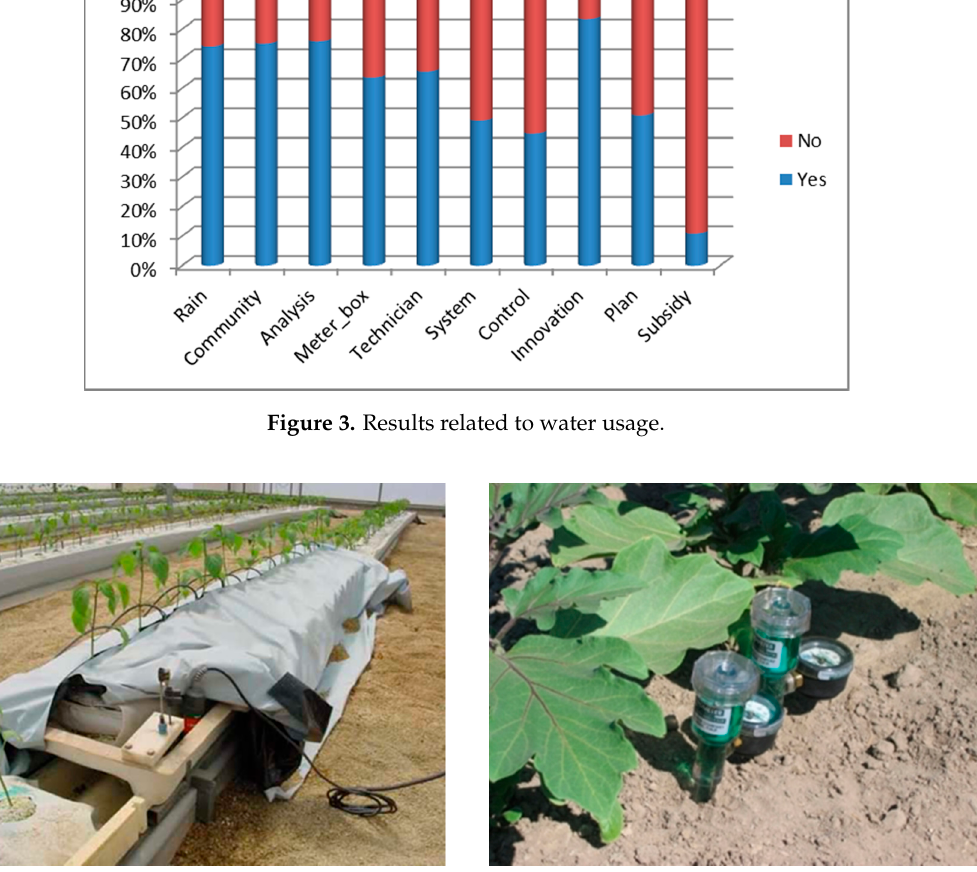
Figure 4. ( a ) Measurement of water level of soil and crops; ( b ) Tensiometer.